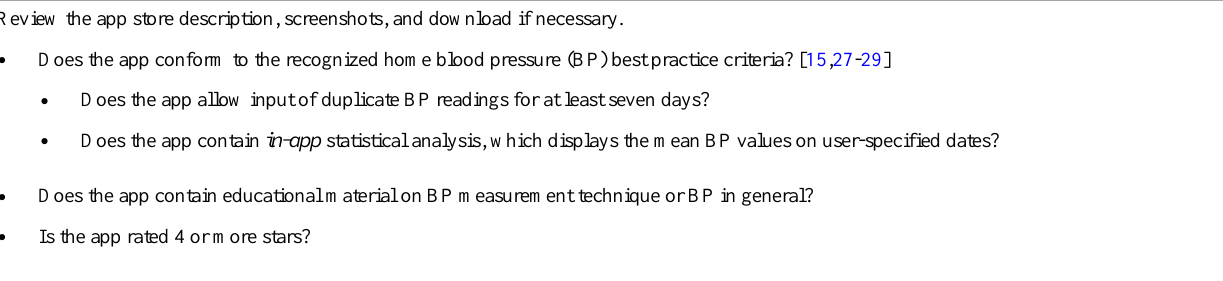
Textbox 1. Proposed simplified, content-dependent criteria to evaluate blood pressure-tracking app quality. Review the app store description, screenshots, and download if